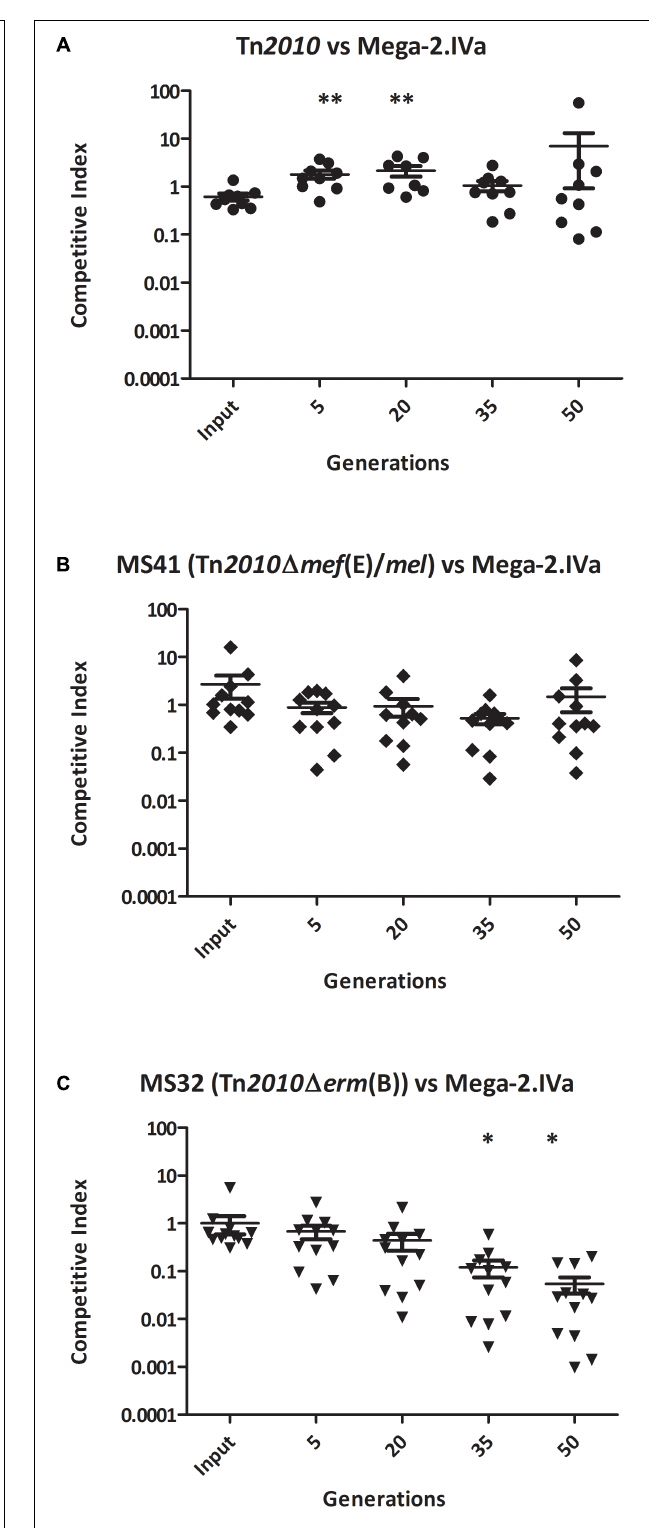
FIGURE 3 | The competitive index of high-level macrolide resistance strains with distinct mechanisms [ erm (B) and Mega-2.Iva] in vitro with erythromycin (0.5 µ g/ml) grown for approximately 50 generations: (A) GA44288 [ erm (B)-and